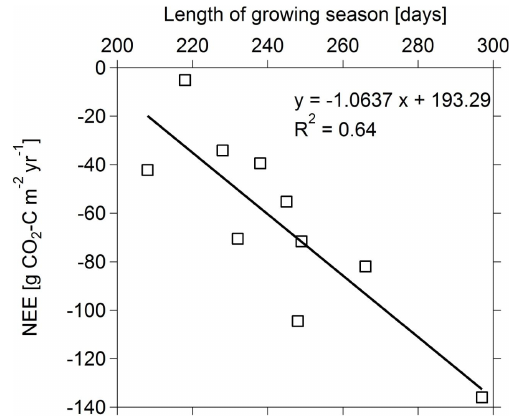
Figure 5. Annual NEE as a function of the length of the growing